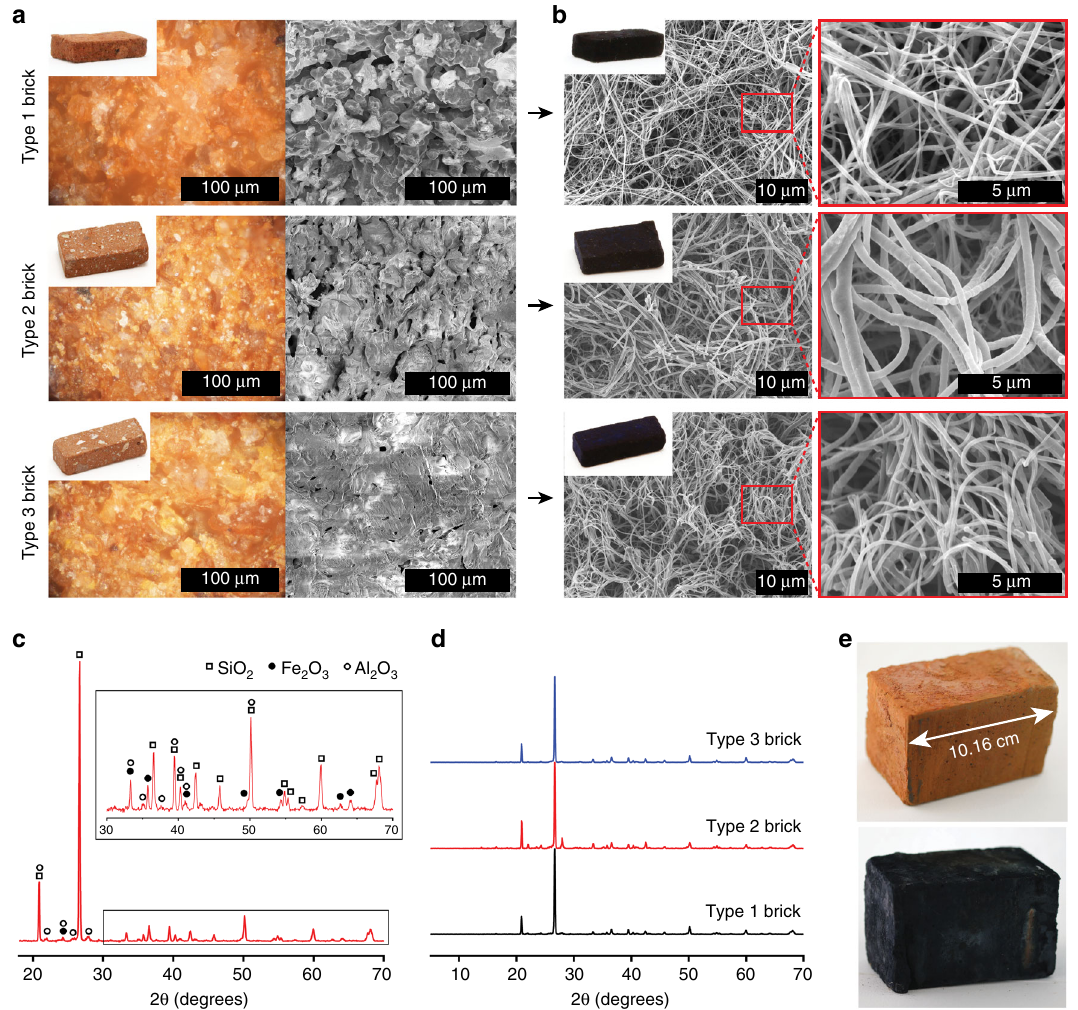
Fig. 2 Nano fi brillar PEDOT-coatings on different types of bricks. a Three types of red fi red bricks are utilized for synthesis. All types show homogeneous red-orange color under the optical microscope, indicating uniform α -Fe 2 O 3 distribution. White spots on bricks (left top inset) show the gravel (SiO 2 ) sizes increasing from type 1 to type 3 brick. Scanning electron micrographs exhibit different porosity for these three types of bricks with pore sizes decreasing from type 1 to type 3. b After synthesis, all types of bricks are homogeneously coated by PEDOT nano fi bers of similar aspect ratio. c Powder X-ray diffraction pattern for type 1 brick shows a composition comprised of SiO 2 , α -Fe 2 O 3 , and Al 2 O 3 . d Type 2 and type 3 bricks show similar patterns and crystalline components. The sharper and stronger peak at 2 θ = 28° from type 2 brick is due to its higher Al 2 O 3 content or crystallinity. e Synthesis is scalable to decimeter-sized